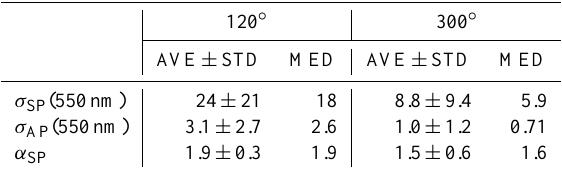
Table 4. Statistics of σ SP and σ AP at λ = 550nm and ˚Angstr¨om ex- ponent of scattering in the 74m altitude wind sectors where average σ SP were highest and lowest. Units as in Table 1.